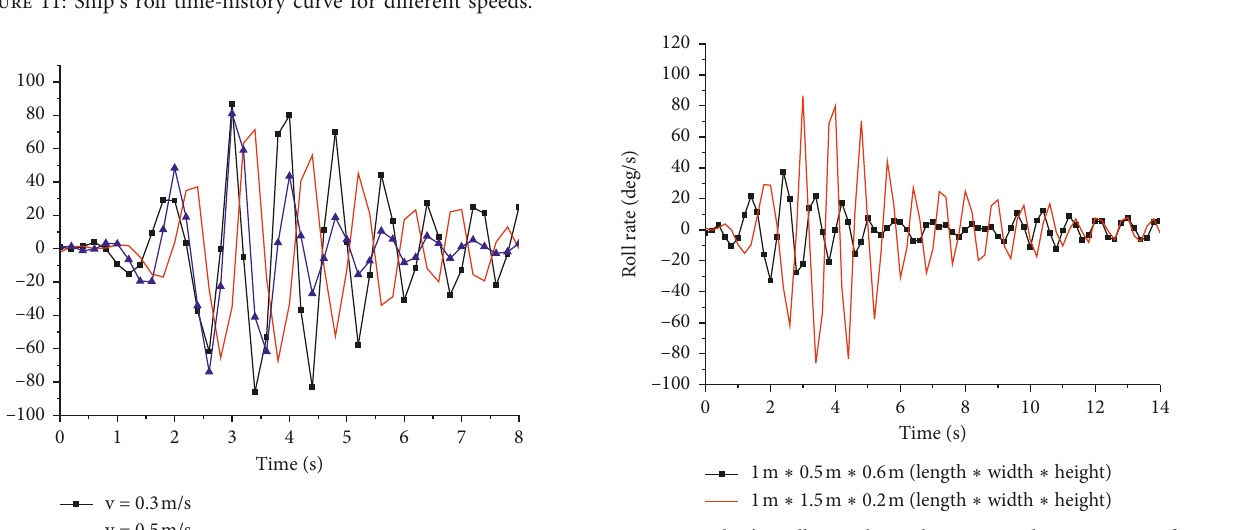
Figure 11: Ship’s roll time-history curve for different speeds.